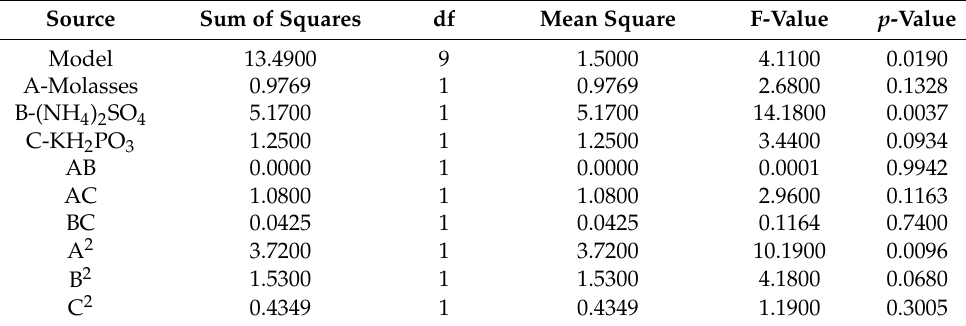
Table 5. Regression results of the central composite design. Sum of